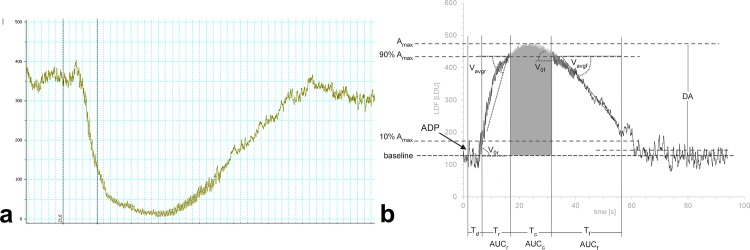
The representative trace of the LDF signal after the intravital injection of ADP to a mouse (a), parameters of the curve calculated by PAMA software, the LDU values are multiplied by -1 and an offset is added to obtain positive values (b).The following parameters characterizing the curve were calculated using PAMA software, as described in ‘Materials and Methods’ and are expressed in arbitrary Laser Doppler Flow units (LDU): Amax—the maximum decrease in blood flow with respect to the baseline; DA–the maximal restoration of flow with respect to the baseline; Td—time from the injection of ADP to 10% of the maximum decrease in blood flow (Amax); Tr−time from 10% to 90% of the maximum decrease in blood flow (Amax); Tc−time from 90% of Amax to 90% of DA; Tf−time from 90% of DA to 10% of DA; V0r
–the maximal rate of the decrease in blood flow; VAvgr−the rate of decrease averaged through Tr; V0f
–the maximal rate of the restoration of blood flow; VAvgf−the rate of restoration averaged through Tf; AUC–the area under the curve from 10% of Amax to 10% DA; AUCr−the area under the curve from 10% to 90% of Amax; AUCc−the area under the curve from 90% of Amax to 90% of DA; AUCf−the area over the curve from 90% to 10% of DA.